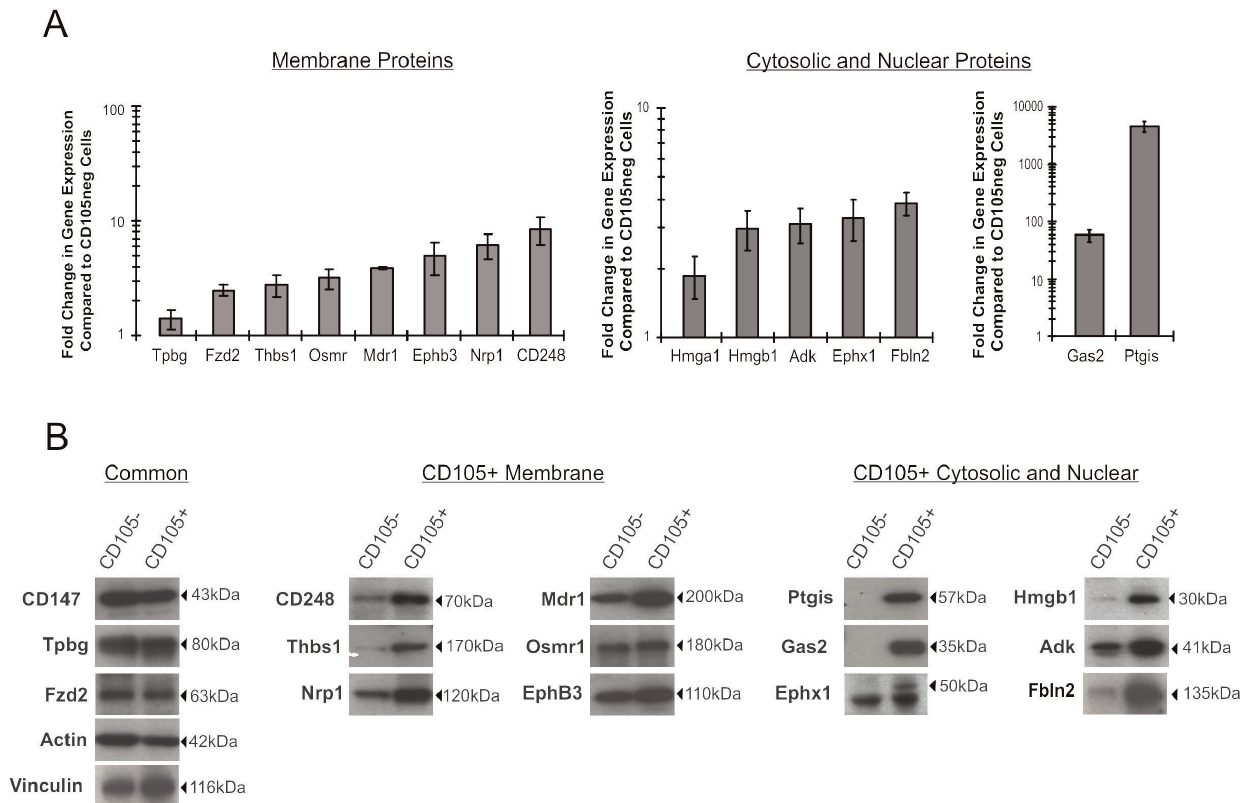
Figure 3. Real-time PCR and Western Blot analysis validate potential markers of MSC that are associated with distinct functional networks. The expression levels of 16 proteins that were identified as either common to all stroma, or unique to CD105 + cells, were chosen for verification based on the availability of reliable antibodies. (A) Comparison of gene expression levels in CD105 + and CD105 2 cells. An aliquot of the CD105 + and CD105 2 cells used for LC MS/MS was utilized for mRNA isolation and converted to cDNA for real-time RT PCR comparison of gene expression (n=3). Results were normalized to GAPDH and fold change in gene expression was determined in comparison to levels detected in CD105 2 cells. (B) Western Blot analysis of protein expression levels in CD105 + and CD105 2 cells. In three separate experiments, whole proteins extracts were obtained from CD105 + and CD105 2 cells grown to the identical passage as used for LC-MS/MS experiments. Equivalent amounts of each protein extract were probed by Western Blot for the presence of common or unique proteins. Analysis of either actin or vinculin expression was completed on each blot to act as a loading control.